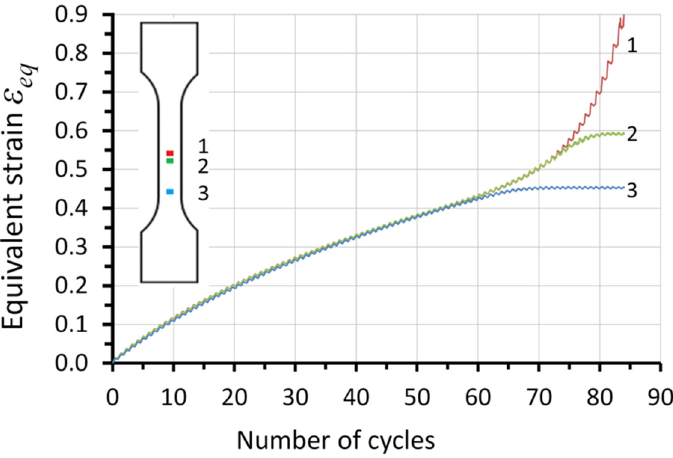
Figure 9. Equivalent strain–number of cycles dependency in the selected sections.